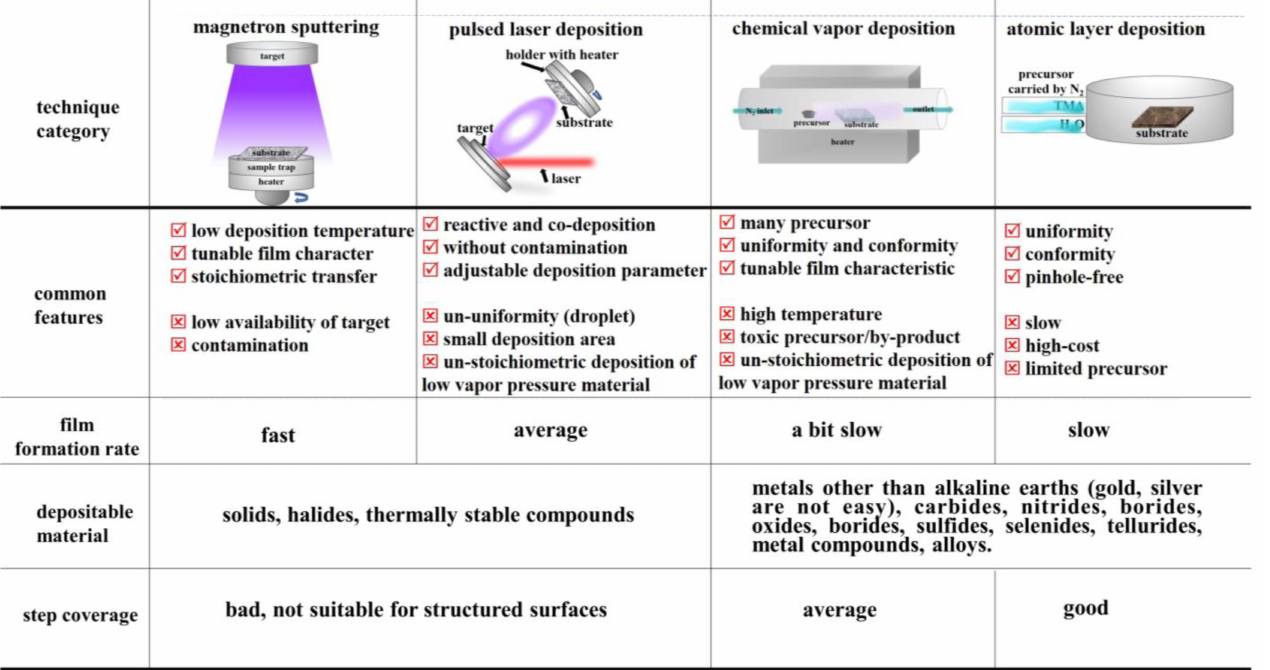
Figure 2. Schematic illustration of main characteristics of advanced deposition